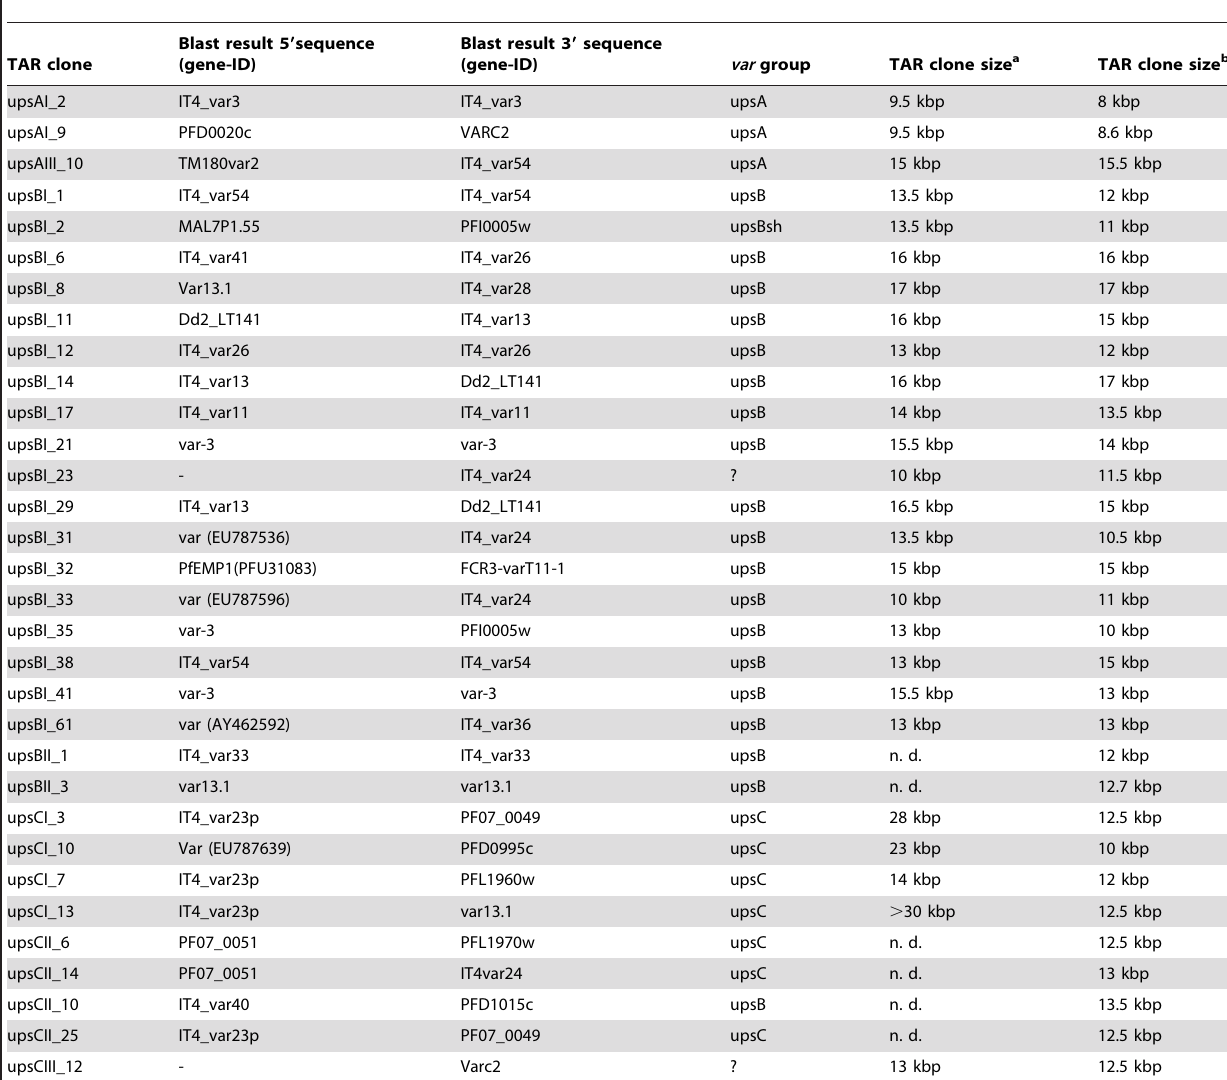
Table 2. Comparison of selected TAR clones by Sanger sequencing of 5 9 and 3 9 ends of inserts and size analysis by Southern blot (a) and RFLP